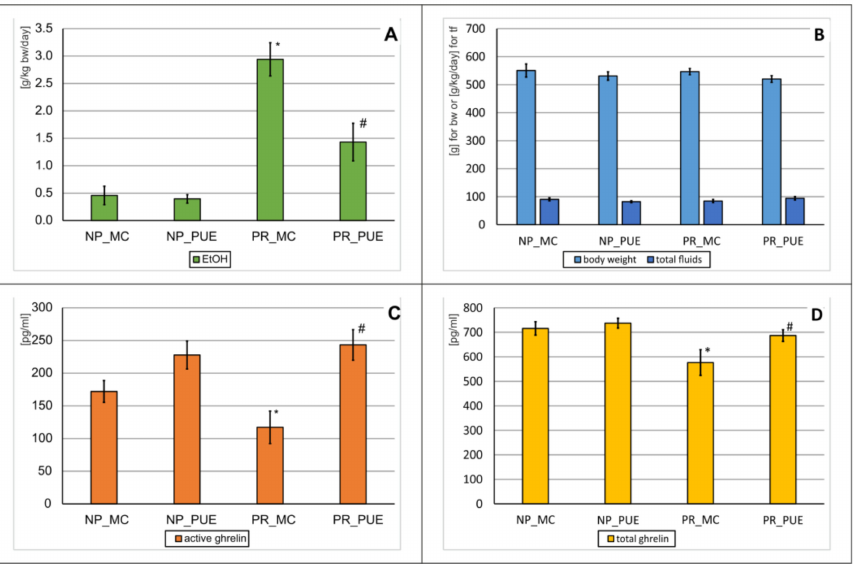
Figure 5. The effect of repeated (28 × ) puerarin (PUE) (150 mg/kg, p.o.) administration on alcohol drinking behavior, total fluid intake, body weight, and ghrelin levels in preferring (PR) and non- preferring (NP) rats. Legend: n = 9–11; mean ± SEM; PR_MC—control PR rats; NP_MC—control NP rats; MC—vehicle (0.5% methylcellulose); ( A ) amount of drunk ethanol [g/kg/day]; *—vs. NP_MC group, p < 0.001; #—vs. PR_MC group, p < 0.001; ( B ) body weight [g] and the total amount of fluid intake [g/kg/day]; ( C ) serum active ghrelin levels [pg/mL]; *—vs. NP_MC group, p < 0.001; #—vs. PR_MC, p < 0.001; ( D ) serum total ghrelin levels [pg/mL]; *—vs. NP_MC group, p < 0.001; #—vs. PR_MC, p <